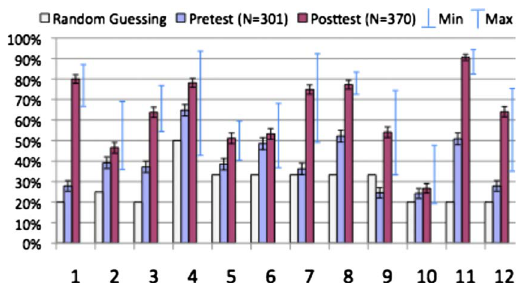
FIG. 3. (cid:1) Color (cid:2) Scores on individual questions in Version 2.0 in modern physics classes. This graph combines data from all five modern physics classes in which all Version 2.0 questions were given. The blue bars on the right show the minimum and maximum average posttest score for